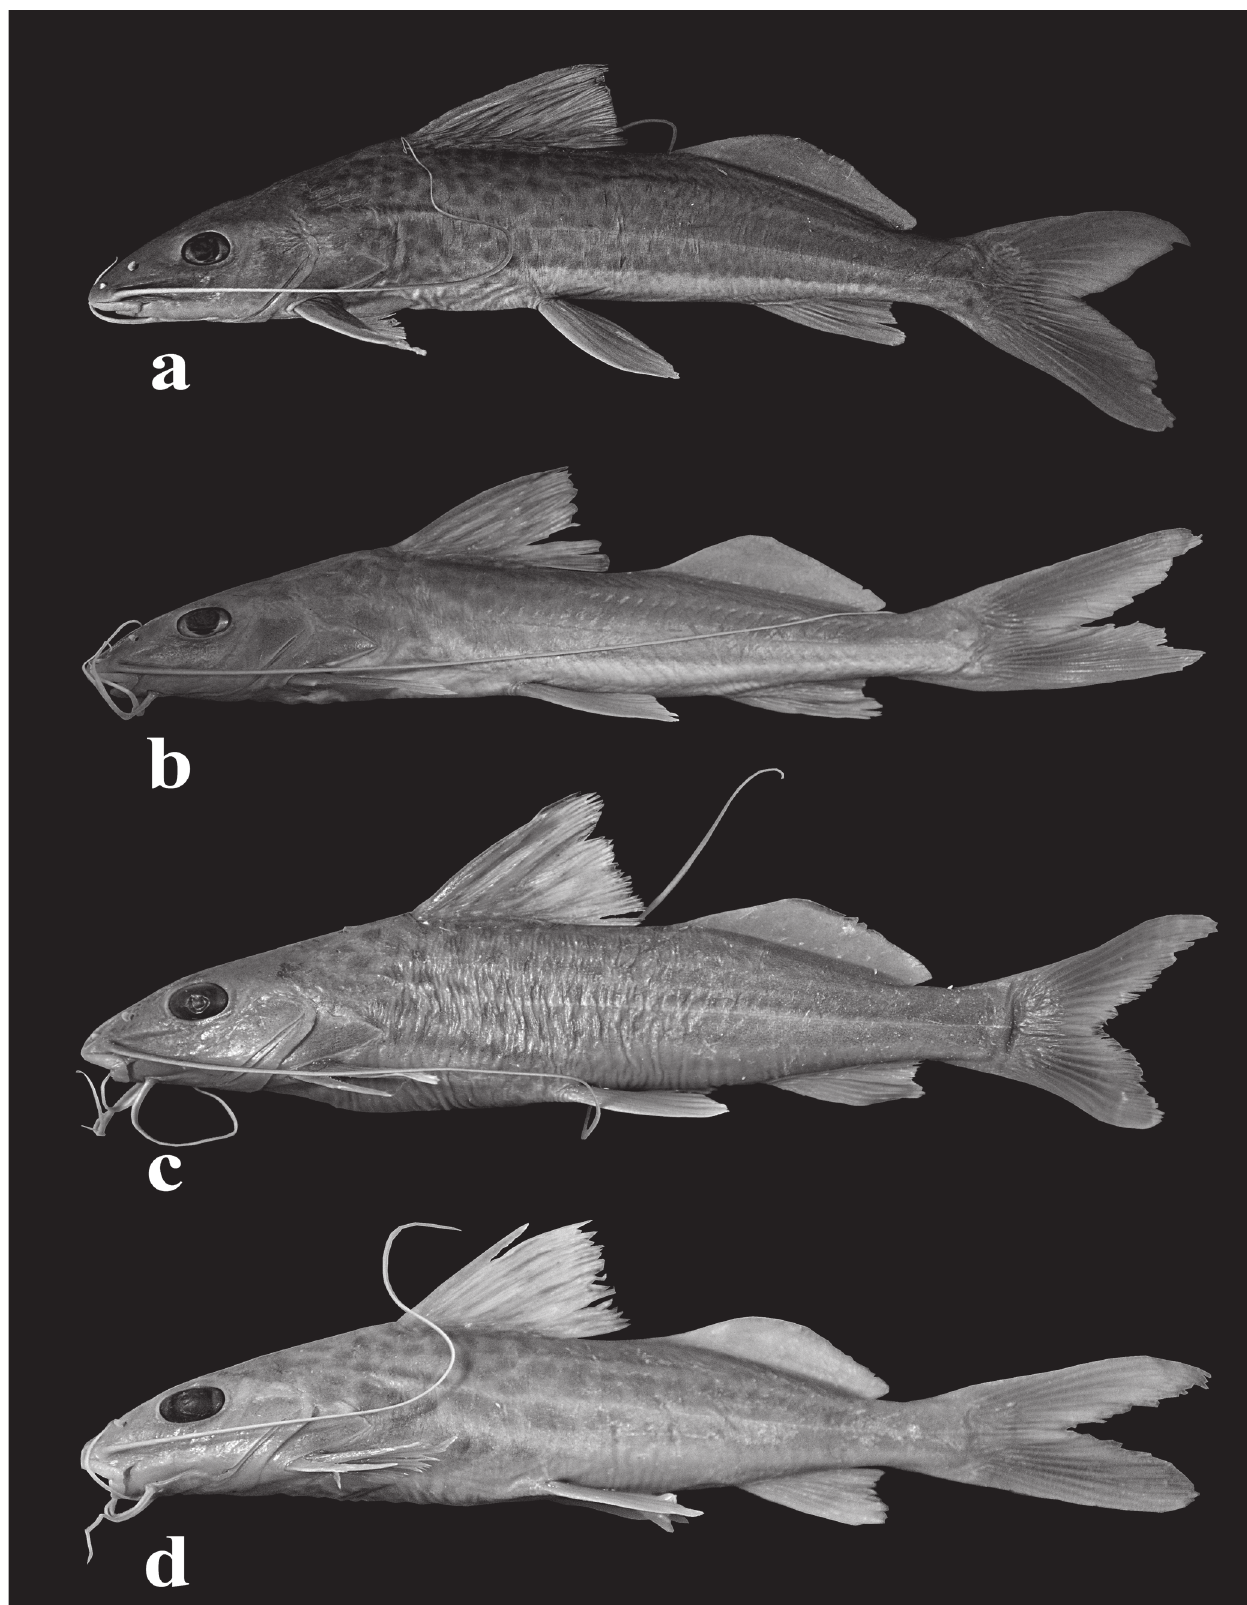
Fig. 1. Lateral view of Pimelodus heraldoi , ( a ) holotype, MZUSP 22713, 179.0 mm SL; and ( b ) MZUSP 105395, 121.5 mm SL; P . microstoma , ( c ) MZUSP 23077, 107.7 mm SL; and ( d ) MZUSP 23077, 91.6 mm